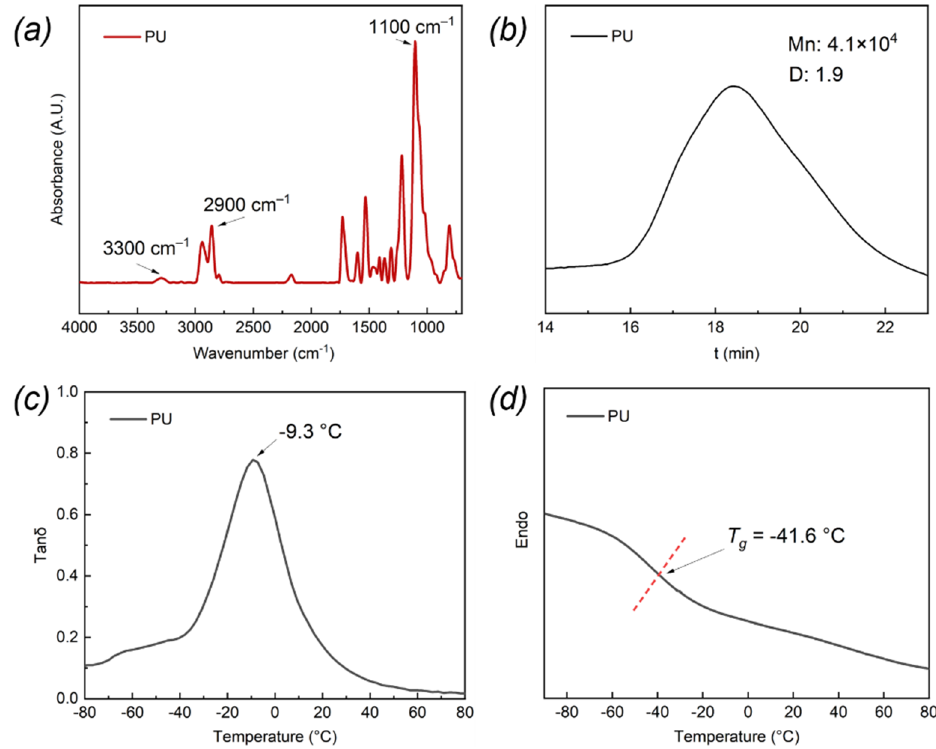
Figure 10. ( a ) FTIR spectrum, ( b ) GPC, ( c ) DMA, and ( d ) DSC curves of the PU ‐ based composite.